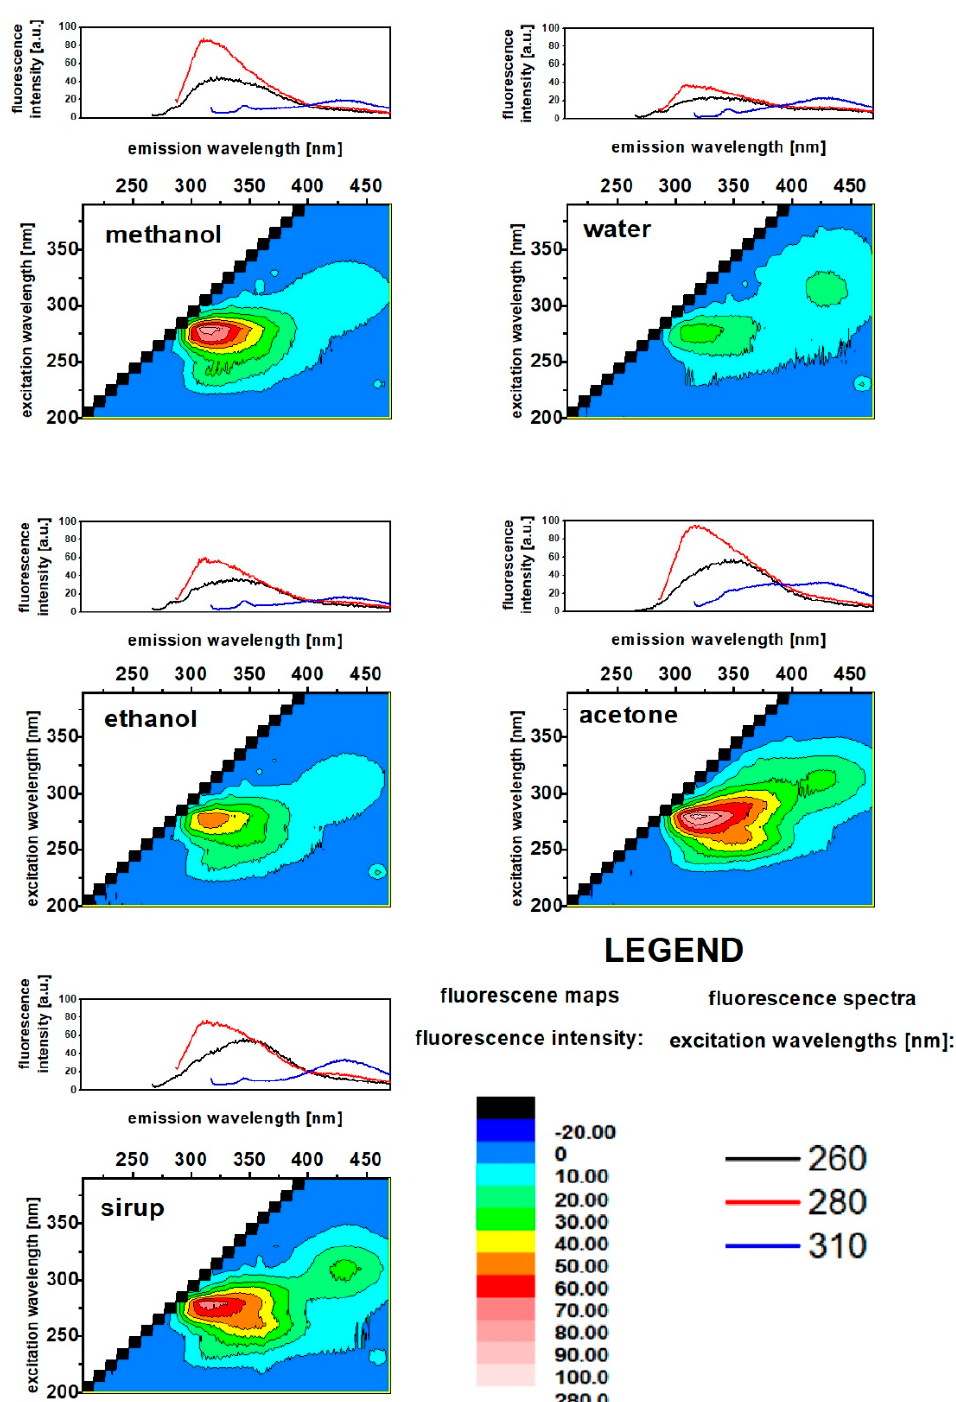
Figure 2. Fluorescence spectra registered for λ ex = 260, 280, and 310 nm and total fluorescence maps of investigated extracts and sirup.